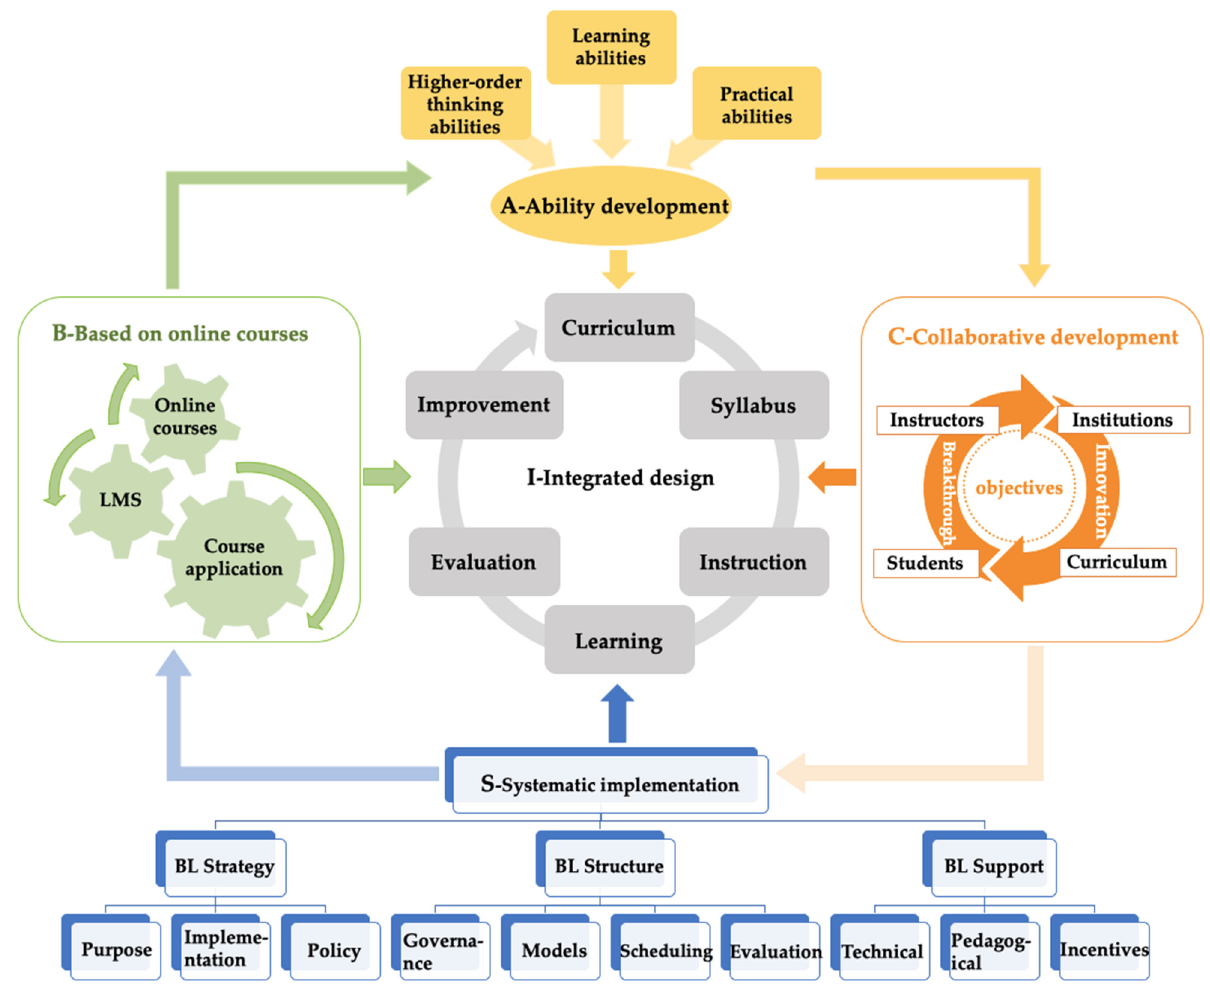
Figure 1. S university’s BASIC model.